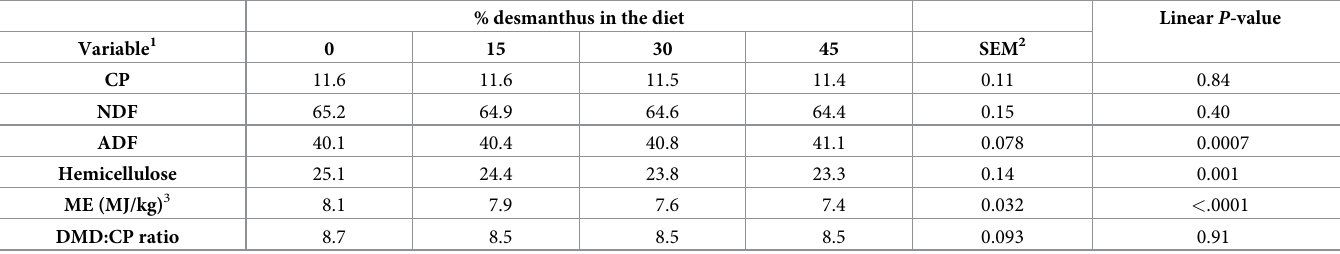
Table 3. Effect of desmanthus proportion on the nutritive value, digestibility and dry matter digestibility to crude protein ratio over the feeding trial duration.